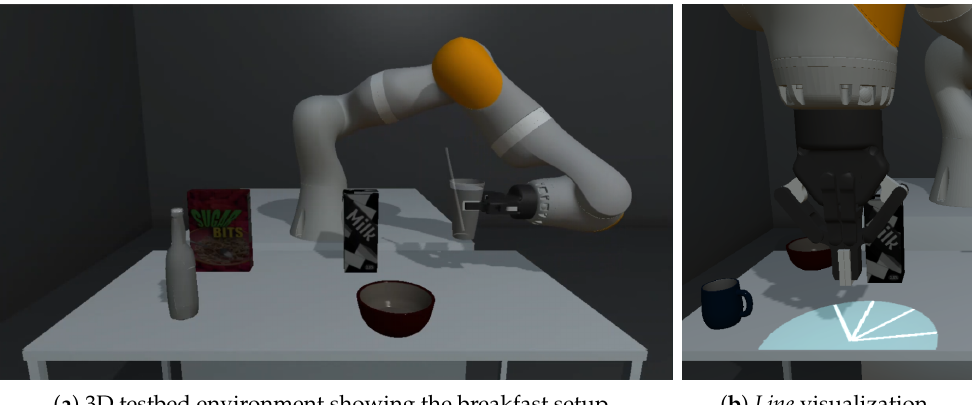
Figure 2. Screenshots of the 3D testbed environment. ( a ): showing the complete setup with the five items placed on the table; ( b ): showing the Line visualization with one object on the table not perceived by the